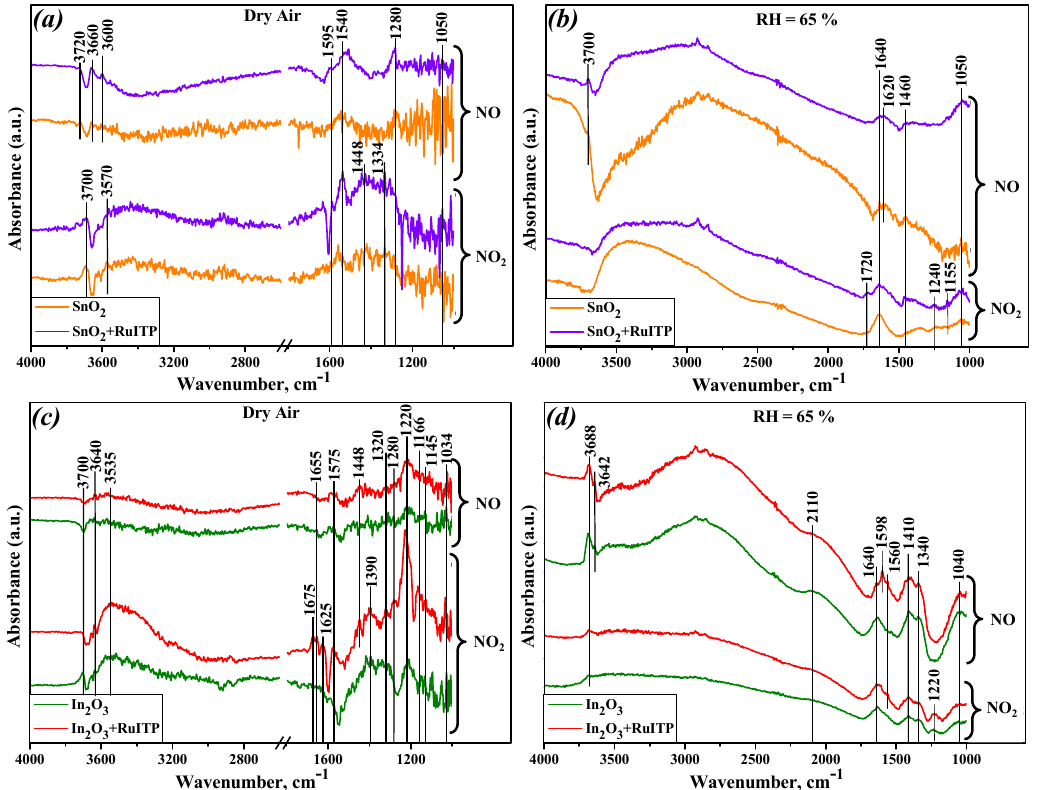
Figure 5. In situ di ff use reflectance infrared Fourier transform spectroscopy (DRIFT) spectra of the nanocrystalline SnO 2 and hybrid SnO 2 +RuITP samples in dry ( a ) and humid (RH = 65%) air ( b ); nanocrystalline In 2 O 3 and hybrid In 2 O 3 +RuITP samples in dry ( c ) and humid (RH = 65%) air ( d ) after 60 min exposure of the NO (50 ppm) and NO 2 (5 ppm) at room temperature.